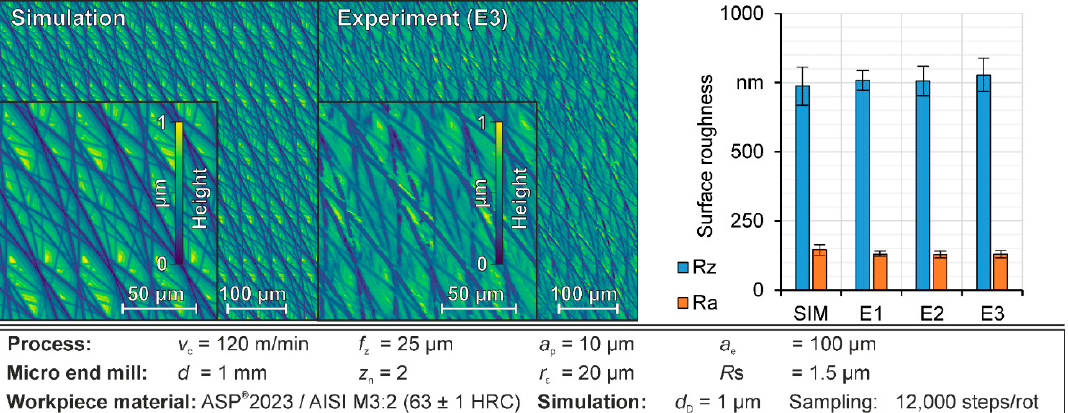
Figure 12. Exemplary validation of the simulation system using three experiments (E1–E3) for a face micromilling process.